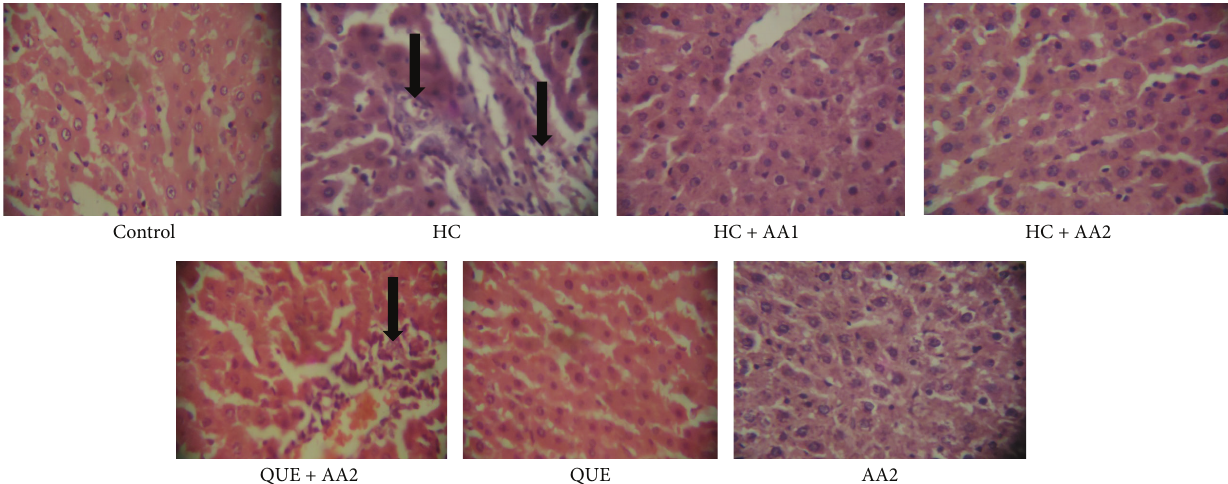
Figure 6: Changes in histology of liver samples of hypercholesterolemic rats treated with Artocarpus altilis and Questran for nine consecutive weeks (M × 400). HC: cholesterol at 30 mg/0.3 mL, AA1: Artocarpus altilis at 100mg/kg, AA2: Artocarpus altilis at 200 mg/kg, and QUE: Questran at 0.26 g/kg. Black arrow shows portal congestion, periportal cellular infiltration, and vacuolar degeneration of